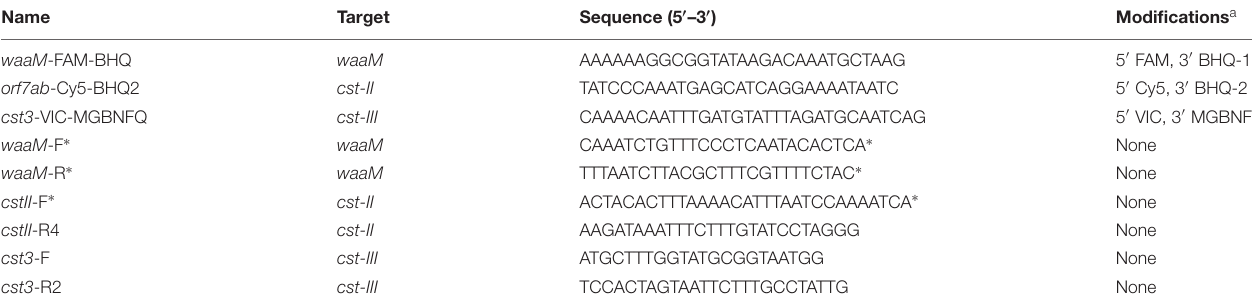
TABLE 1 | Oligonucleotides used in this study.